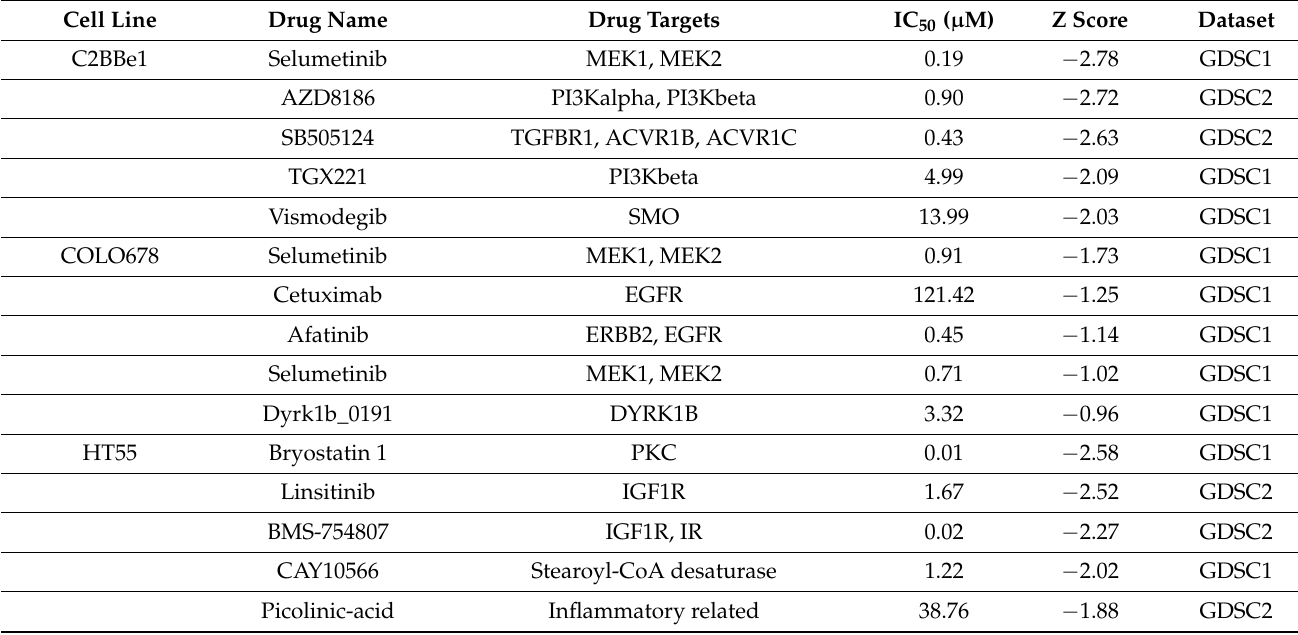
Table 4. Top-5 drugs with z-scores in cell lines with 20q11.21 amplifications. Data are from Genomics of Drug Sensitivity in Cancer datasets (GDSC1 and GDSC2, www.cancerrxgene.org, accessed on 6 April